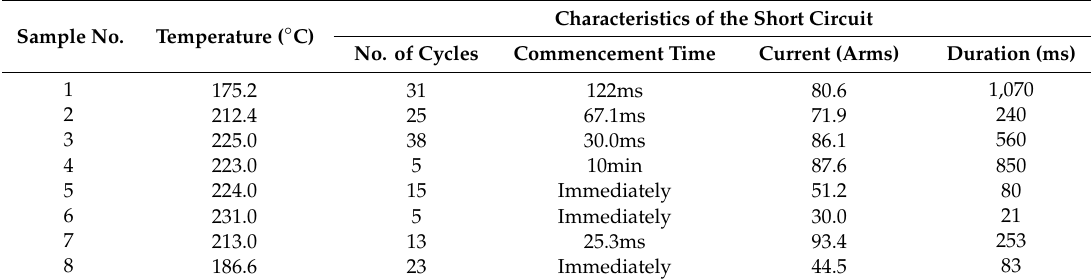
Table 3. Experimental results for the partially broken samples.